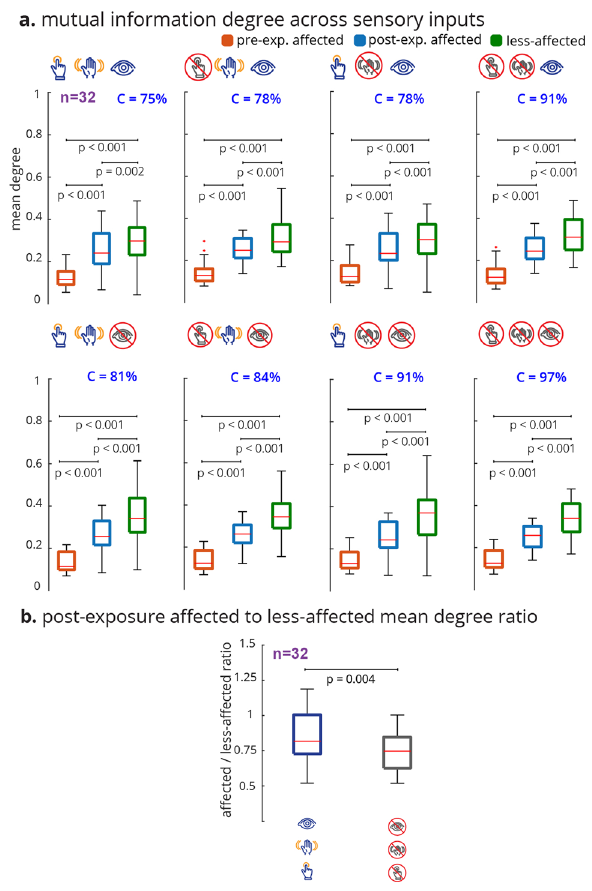
Figure 8. The mutual information degree across sensory conditions. For each subject and sensory condition, the median muscle network across all trials was computed. The mean degree was then calculated for that median muscle network. ( a ) For all conditions, the mean degree ascended monotonically with statistical significance from pre-exposure affected to post-exposure affected to less-affected limbs. ( b ) The ratio of the post-exposure affected to less-affected mean degree distributions was computed for all (none blocked) vs no (all blocked) sensory feedback conditions. Wilcoxon sign rank test shows a significant difference between the mean degree ratio distributions. The affected limb’s muscle network approached that of the less-affected limb with sensory feedback compared to without sensory